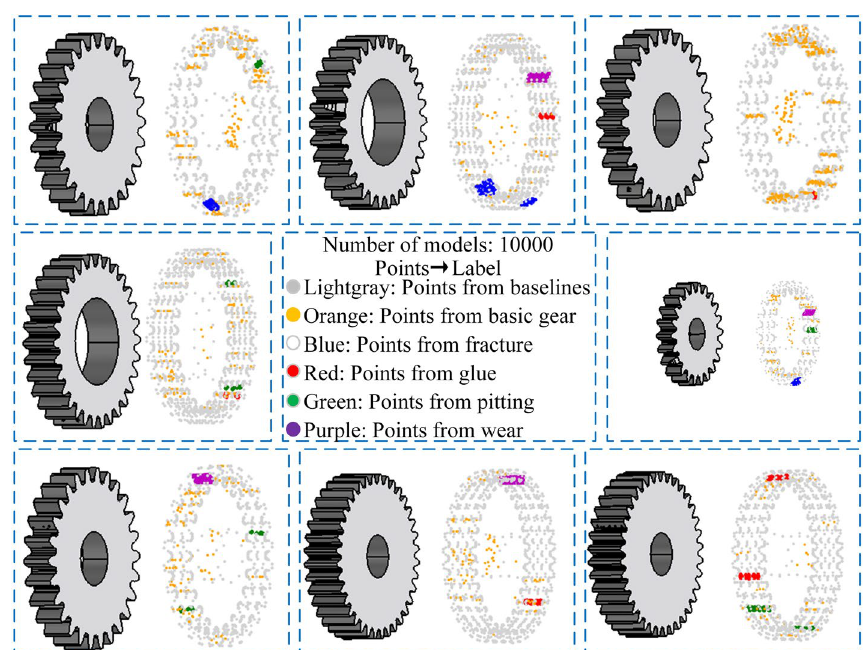
Fig. 2 Gear data set with defects. The light gray, orange, blue, red, green, and purple spheres represent points of baselines, basic gear, fracture, glue, pitting, and wear, respectively